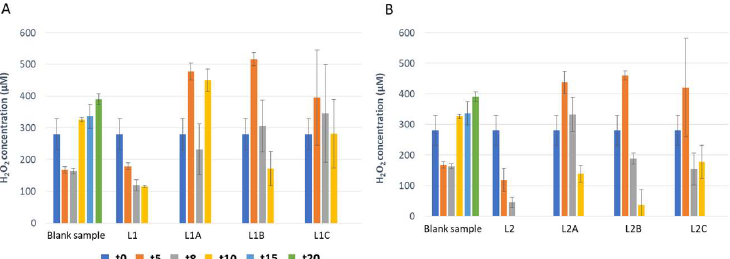
Figure 1. Hydrogen peroxide concentration examined in mozzarella samples contaminated with P. fluorescens (5026) over the shelf life. The covering liquid was inoculated with 2 Log CFU/mL ( A ) and 4 Log CFU/mL ( B ).